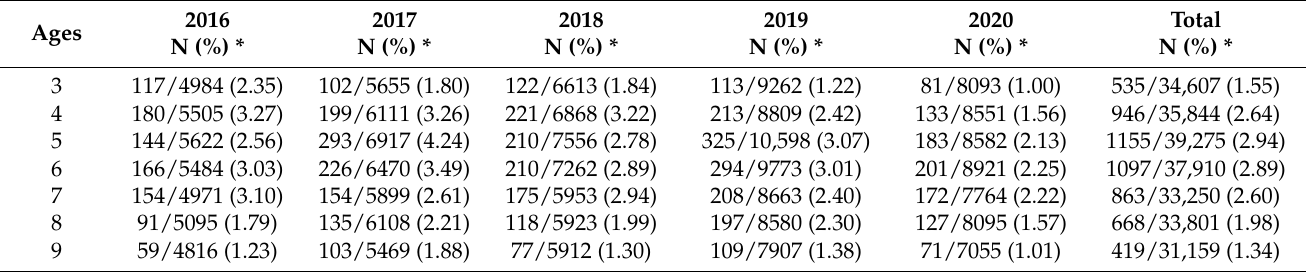
Table 3. Enterobius vermicularis infection among children by ages in China from 2016 to